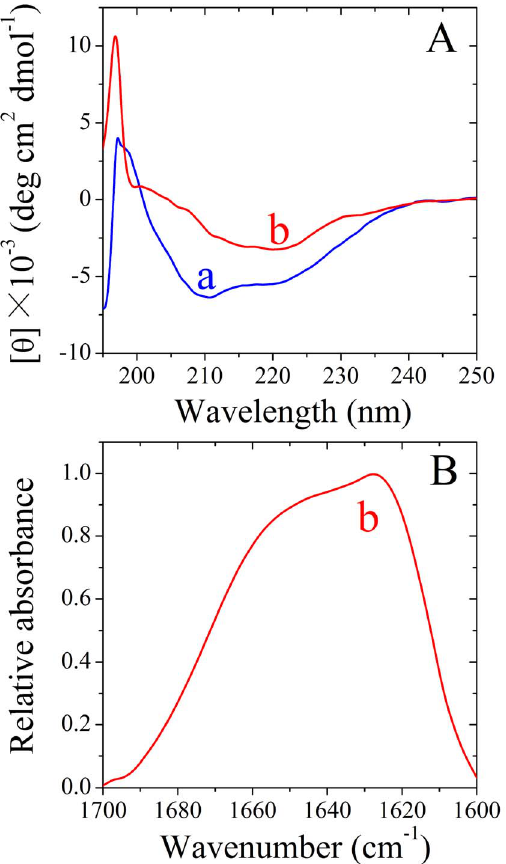
Figure 9. Secondary structural changes of chimera R isoforms in the presence of Ficoll 70 monitored by far-UV CD (A) and FTIR (B). Curve a: native chimera R. Curve b: amyloid fibrils produced from chimera R in the presence of 150 g/l Ficoll 70. The incubation time was chosen within a time range of the plateau of each kinetic curve of ThT fluorescence shown in Fig. S1.